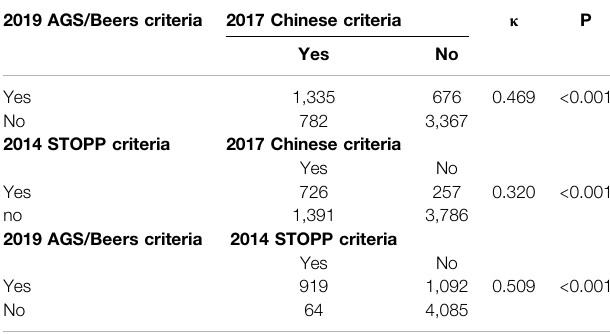
TABLE 2| Concordancebetweenthe2017Chinese,2019AGS/Beers, and 2014 STOPP criteria. 2019 AGS/Beers criteria 2017 Chinese criteria